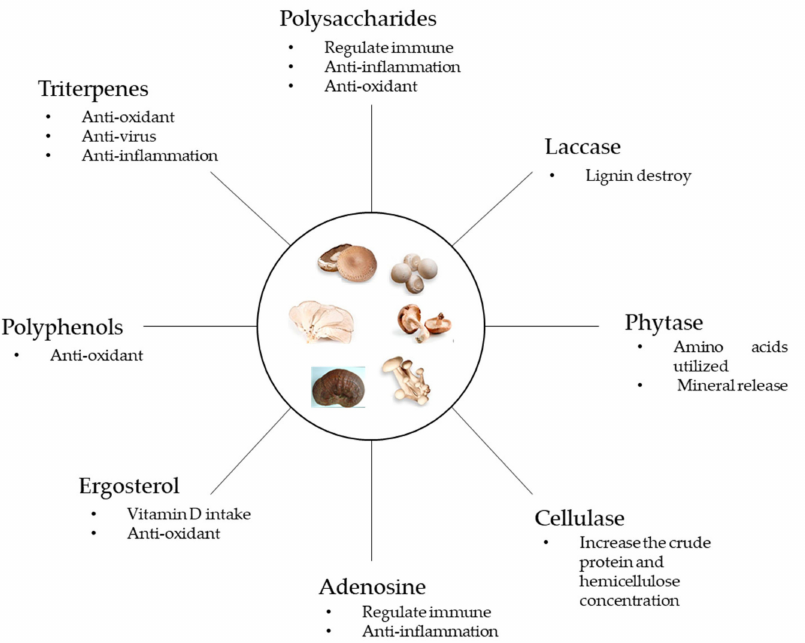
Figure 1. Fungal compounds and their potential functions. Mushroom images were adapted from Du et al. [42], and the photograph of Ganoderma was taken by the